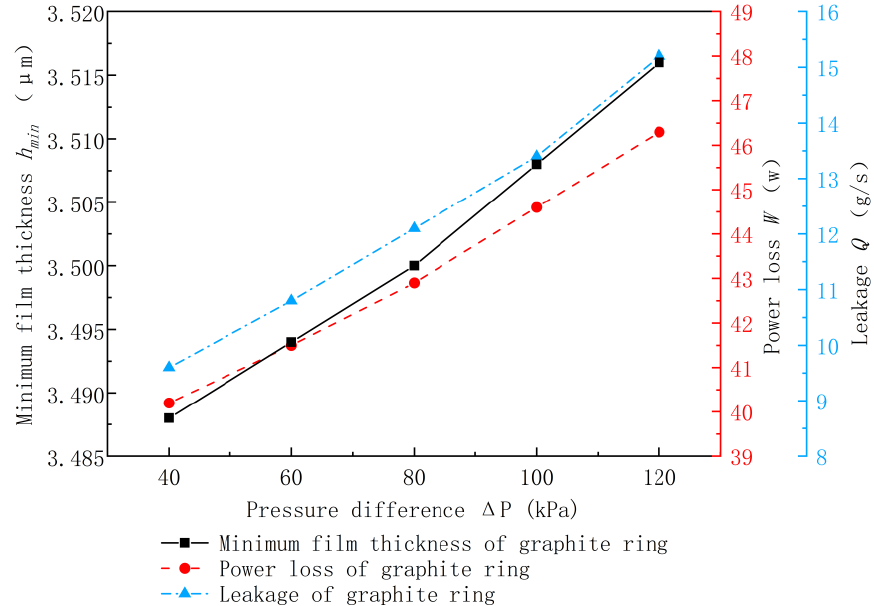
Figure 14. Effects of differential pressure on sealing performance.